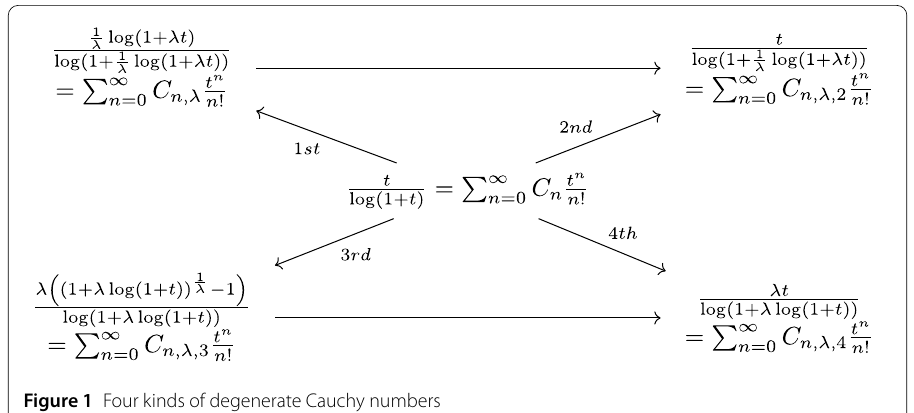
Figure 1 Four kinds of degenerate Cauchy